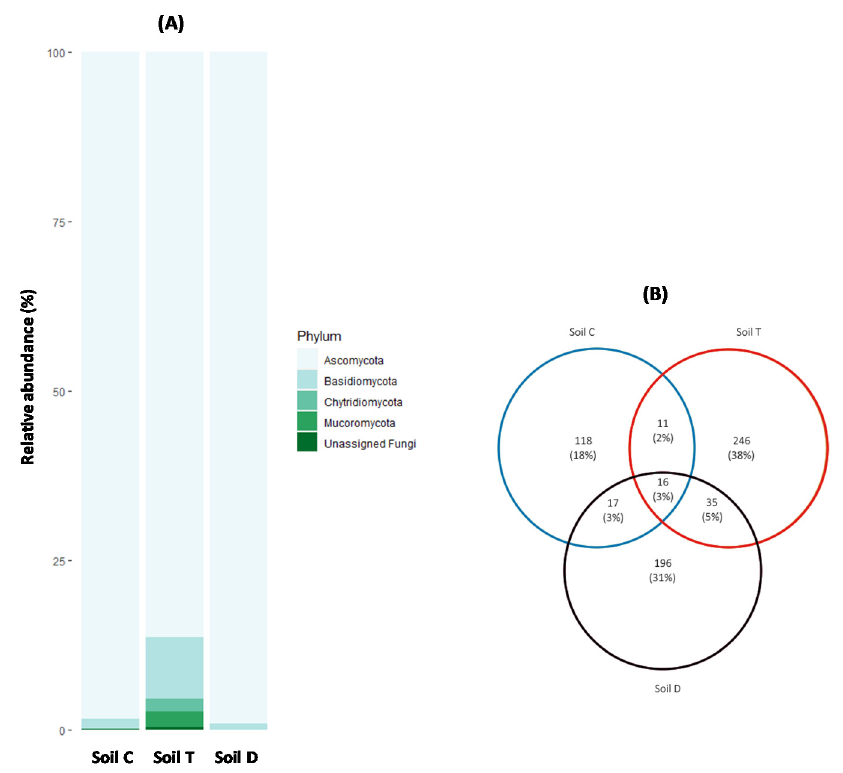
Figure 3. Comparison of fungal communities of the studied soils at phylum ( A ) and OTU ( B ) levels.